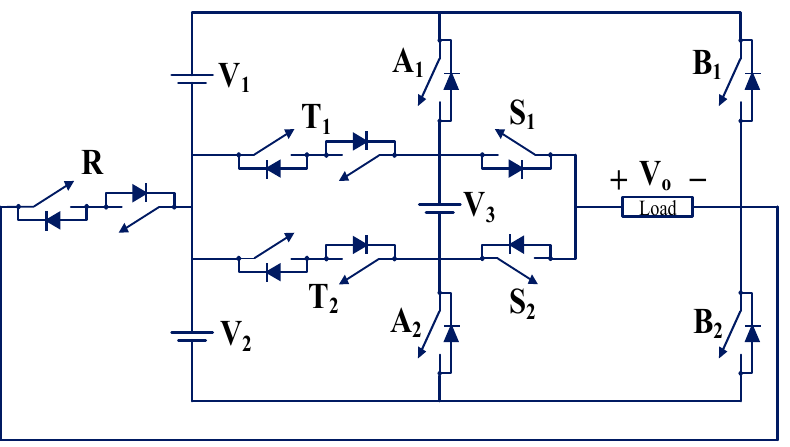
Figure 13. Single-phase thirteen-level inverter with fault tolerance capability (TP13) [52].